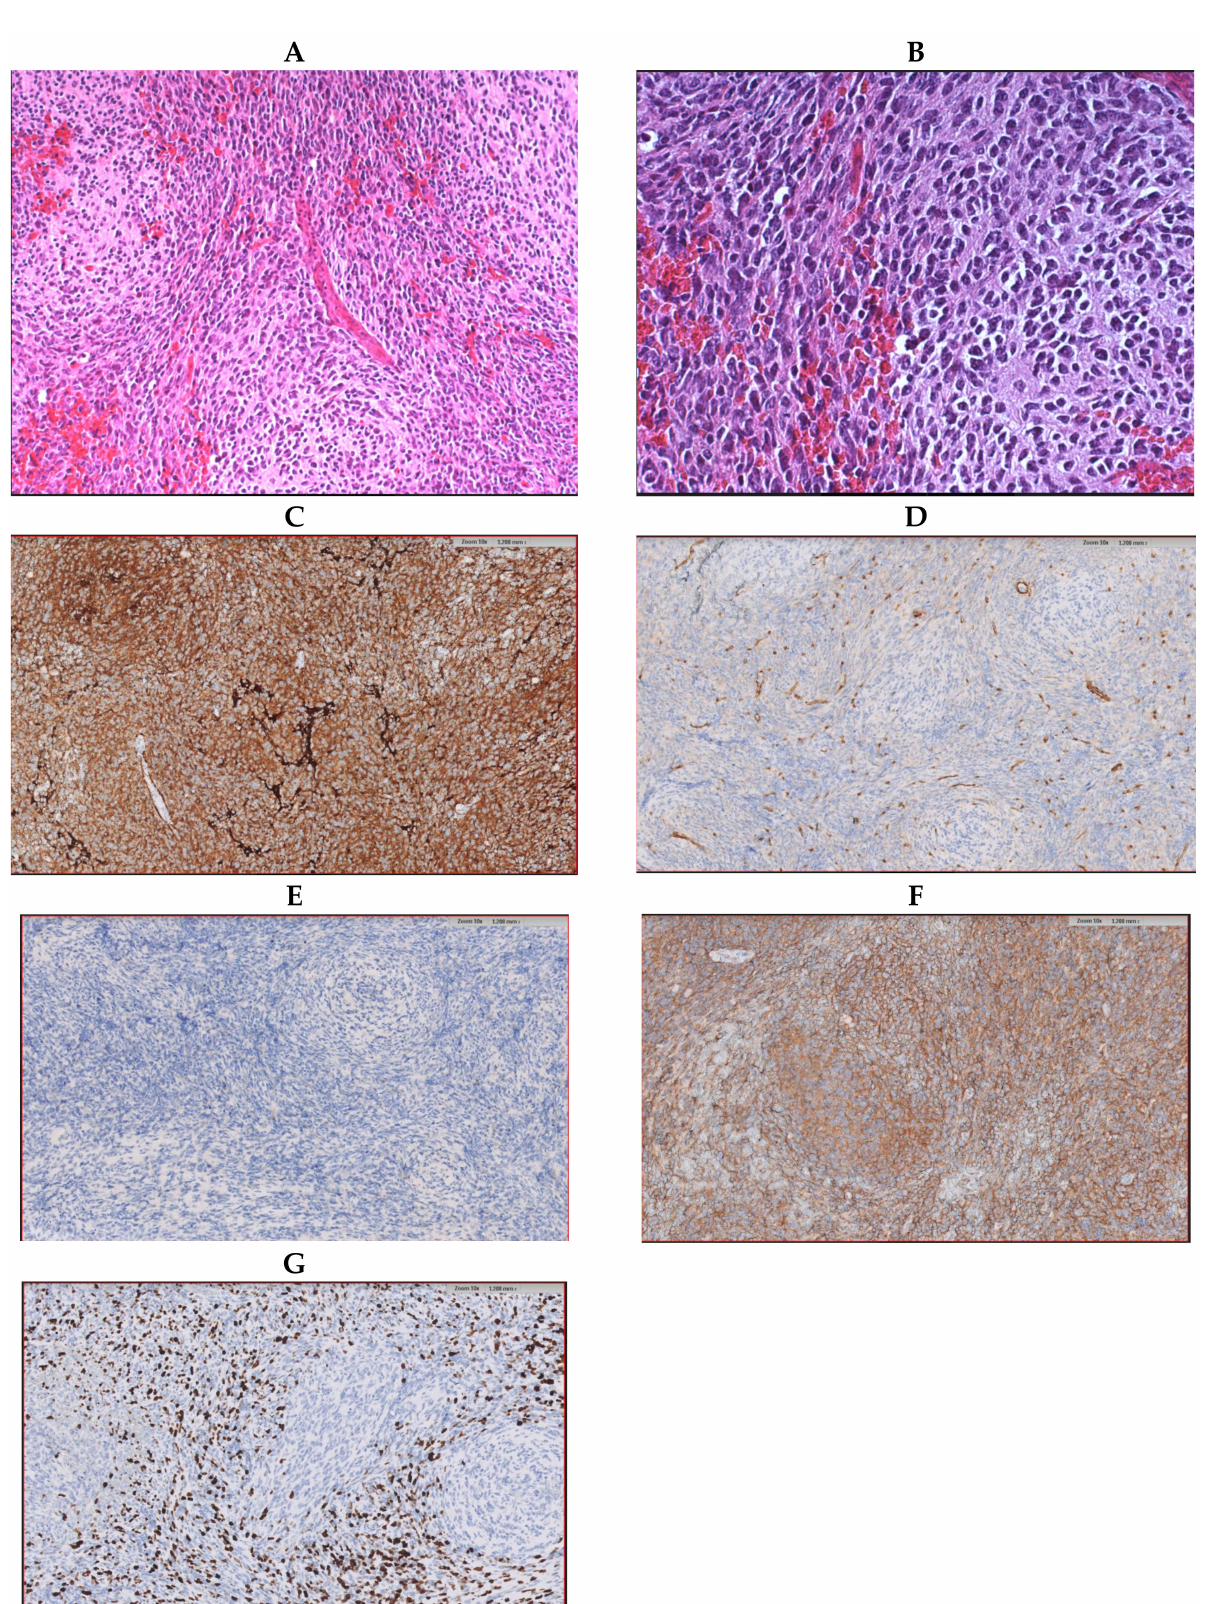
Figure 1. Histological samples preparation of the tumor (hematoxylin-;eosin coloration) showing a vague nodular pattern ( A ) without an increase in reticulin ( B ). Immunohistochemical samples revealing the diffused expression of synaptophysin ( C ), YAP1 solely expressed by the endothelial cells ( D ), no expression of GAB1 ( E ), the expression of Beta-catenin limited to the cytoplasm ( F ), and a high expression of Ki67 in the internodular areas ( G